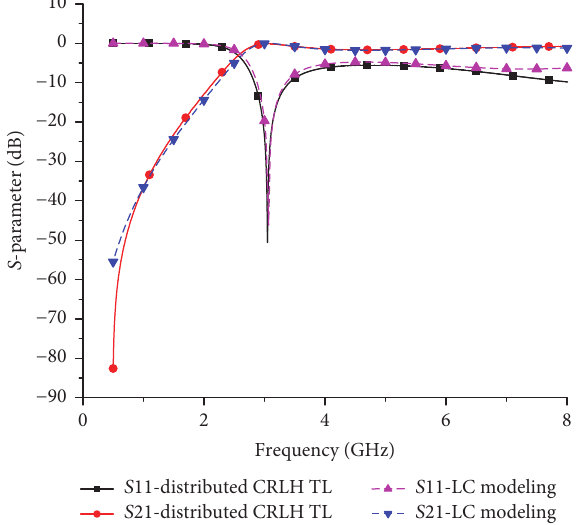
Figure 6: Extracted LC parameters of equivalent LC circuit model. Figure 7: Comparison of 𝑆 -parameters between distributed 1-cell CRLH TL and equivalent LC circuit